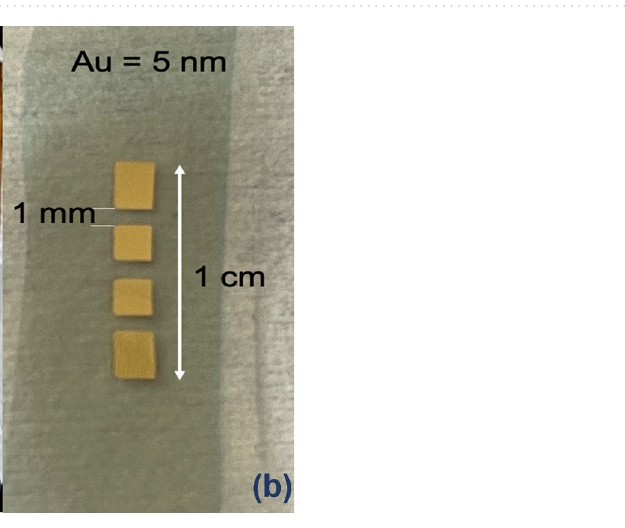
Figure 9. Atomic force microscopy analysis. Morphological data of the Au films sputtered on SA (upper panels) and PMMA (lower panels) films supported on glass.